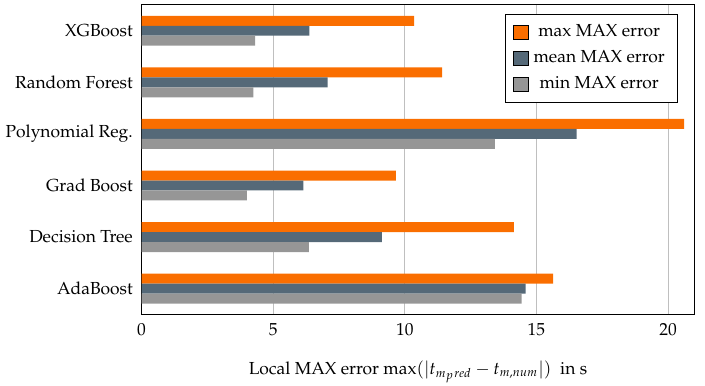
Figure 12. Comparison of local errors (MAX error) for all examined methods on the demonstrator